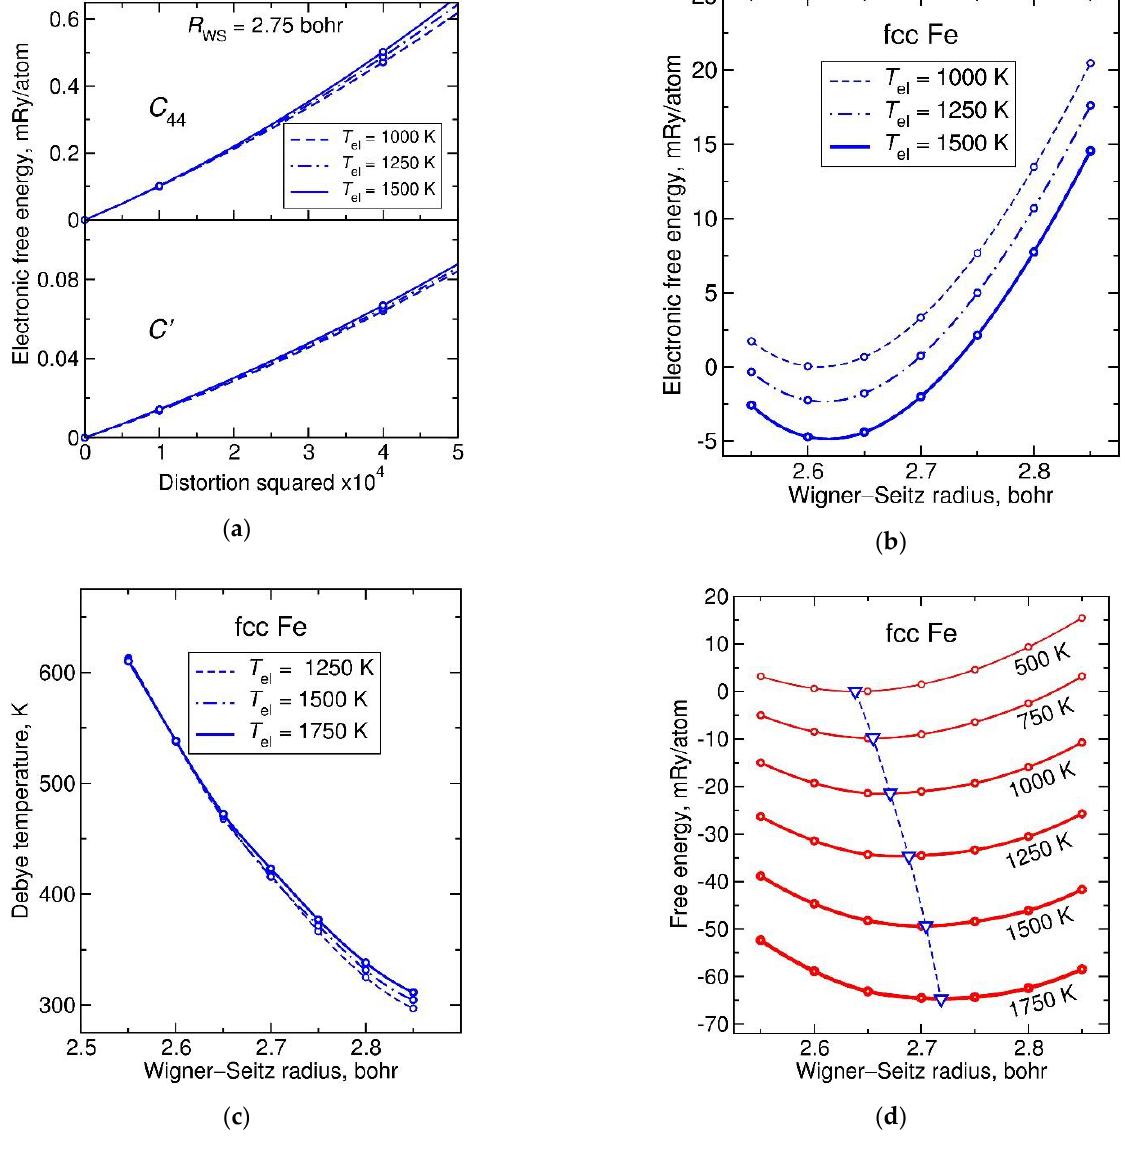
Figure 3. Parameterization of the Debye model using elastic constant calculations for paramagnetic fcc Fe, a metal with an open d -electron shell: ( a ) electronic free energy dependencies on two shear distortions, to calculate 𝐶 44 and 𝐶′ at each considered 𝑅 WS and 𝑇 el ; ( b ) electronic free energy dependence upon isotropic strain, to calculate adiabatic bulk modulus 𝐵 el (𝑉 , 𝑇 el ) ; ( c ) Debye temperature estimated from 𝐶 44 , 𝐶′ , and 𝐵 el ; ( d ) Helmholtz free energy obtained by adding the vibrational free energy in the Debye model to the electronic free energy. Dashed line with down triangles indicates the temperature-dependent equilibrium volume.